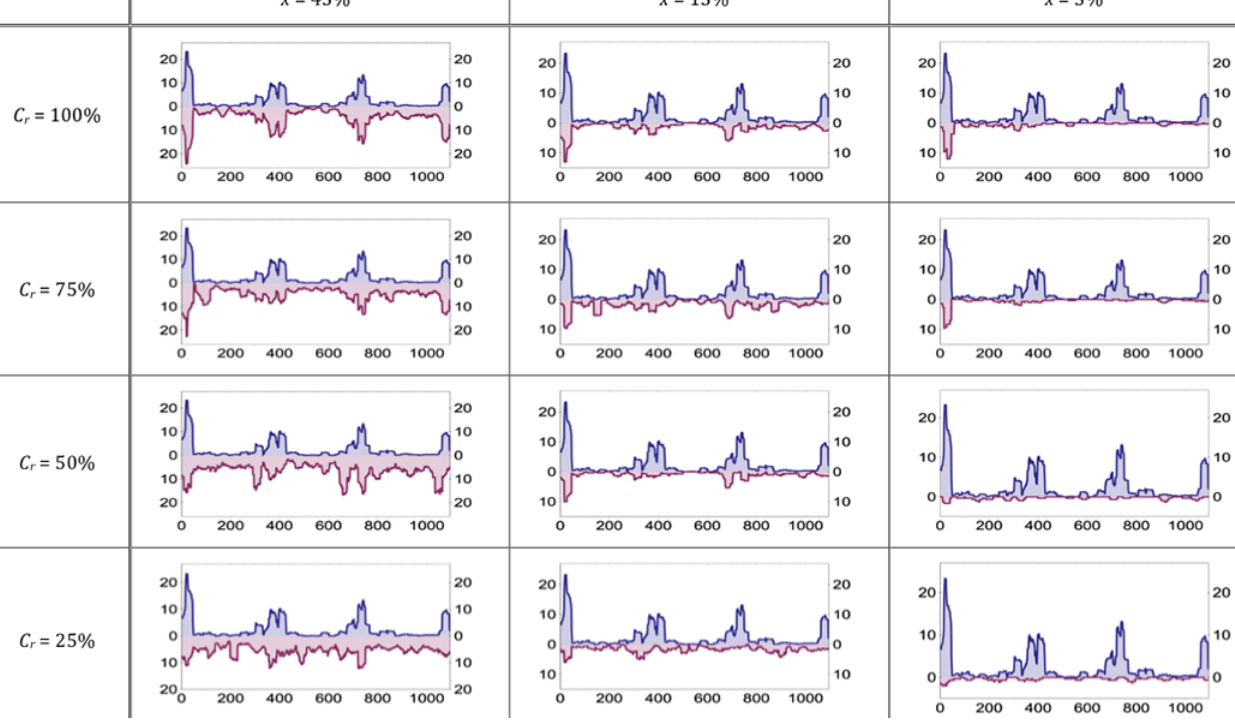
Figure 4. Qualitative correlation between rockfalls and rainfall (30-day moving average) for the 12 virtual databases. C r corresponds to the “correlation rate” between rainfall and number of events, and x corresponds to the proportion of days with events. The x axis shows days. The y axis shows daily rainfall in mm (above zero) versus the number of rockfalls (below